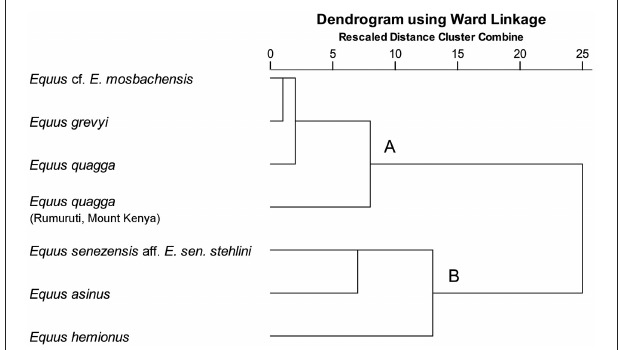
FIGURE 2 | Mesowear hierarchical cluster diagram based on the percentage of high occlusal relief, round and blunt cusps of fossil populations with extant equids. (Data for extant equids from Fortelius and Solounias, 2000; Schulz et al., 2007; Rivals and Semprebon,